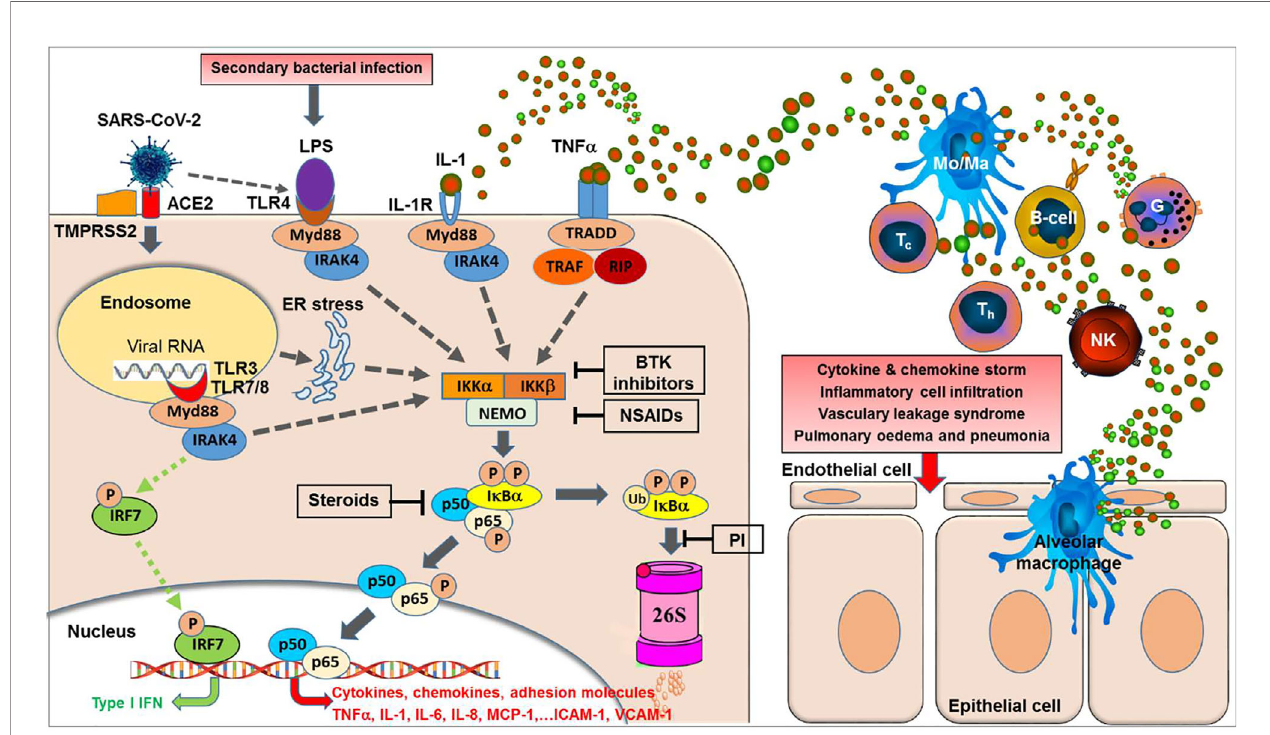
FIGURE 1 | NF- k B activation is central to the acute respiratory RNA virus-induced cytokine storm. Binding of SARS-CoV-2 to its receptor, i.e. the angiotensin- converting enzyme 2 (ACE2) and the help of the cellular serine protease TMPRSS2 trigger endocytosis into the host cell. Within the endosomes, RNA from single- stranded RNA virus is known to activate the Toll-like receptors TLR7 and TLR8. Double-stranded RNA intermediates generated during viral replication can be recognized by TLR3. TLR7/8 and/or TLR3 activation can lead to activation of transcription of the interferon-regulator factor (IRF) family and antiviral responses (green dotted lines). However, as a second major effect the activation of the TLRs can trigger — via various intermediates — the activation of IKK (I k B kinases) (gray dotted lines) resulting in phosphorylation of the cytoplasmic inhibitor factor I k B a triggering its ubiquitination followed by degradation by the 26S proteasome, thereby NF- k B (a heterodimer complex consisting of protein subunits p50 and p65) is released from I k B a and can now enter the nucleus and initiate transcription of various genes coding for pro-in fl ammatory proteins such as cytokines, chemokines, adhesion molecules, and growth factors. Importantly, this fi nal sequence of NF- k B activation is shared with a multiple range of cytokine receptor- and Toll-like receptor mediated signal cascades, including binding of TNF a or IL-1 to their receptors or binding of LPS (e.g. from secondary bacterial infections) to TLR4. Furthermore, SARS-CoV-2 was reported to induce TLR4-mediated NF- k B activation as well as ER stress- induced NF- k B activation. Excessive NF- k B activation triggers the gene expression for a broad range of pro-in fl ammatory cytokines and chemokines, adhesion molecules, and acute phase proteins, resulting in in fl ammatory cell activation and in fi ltration, vascular leakage syndrome, fi nally leading to pulmonary edema and pneumonia. In contrast, interferon-response factor (IRF)-related antiviral responses are largely independent on NF- k B translocation. BTK inhibitors, Bruton Tyrosine Kinase inhibitors; PI, proteasome inhibitors; NSAIDs, nonsteroidal anti-in fl ammatory drugs; TNF a , tumor necrosis factor-alpha; IL-1, interleukin-1; MCP-1, macrophage chemotactic protein-1; ICAM-1, intercellular adhesion molecule-1; VCAM-1, vascular cell adhesion molecule-1; IRF7, interferon regulatory factor-7; Type I IFN, interferon type I; Myd88, myeloid differentiation primary response 88 protein (adaptor molecule); NEMO, NF- k B essential modulator; IKK, I k B kinase; TRAF, TNF receptor-associated factor; RIP, receptor-interacting protein; TRADD, tumor necrosis factor receptor type-1 associated DEATH domain protein; IRAK4, interleukin-1 receptor-associated kinase 4; ER, endoplasmatic reticulum; LPS,